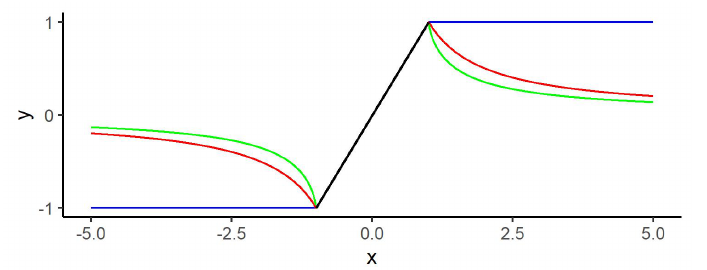
Figure 6. Extension the function f ( s ) = s for s ∈ [ − 1,1 ] using three different methods. In black, the original function, f ; in blue F 1 , the mean of the McShane and Whitney formulas; in red F 2 , the one by Oberman and Milman; and in green F 3 , the 2 − average slope minimizing extension.